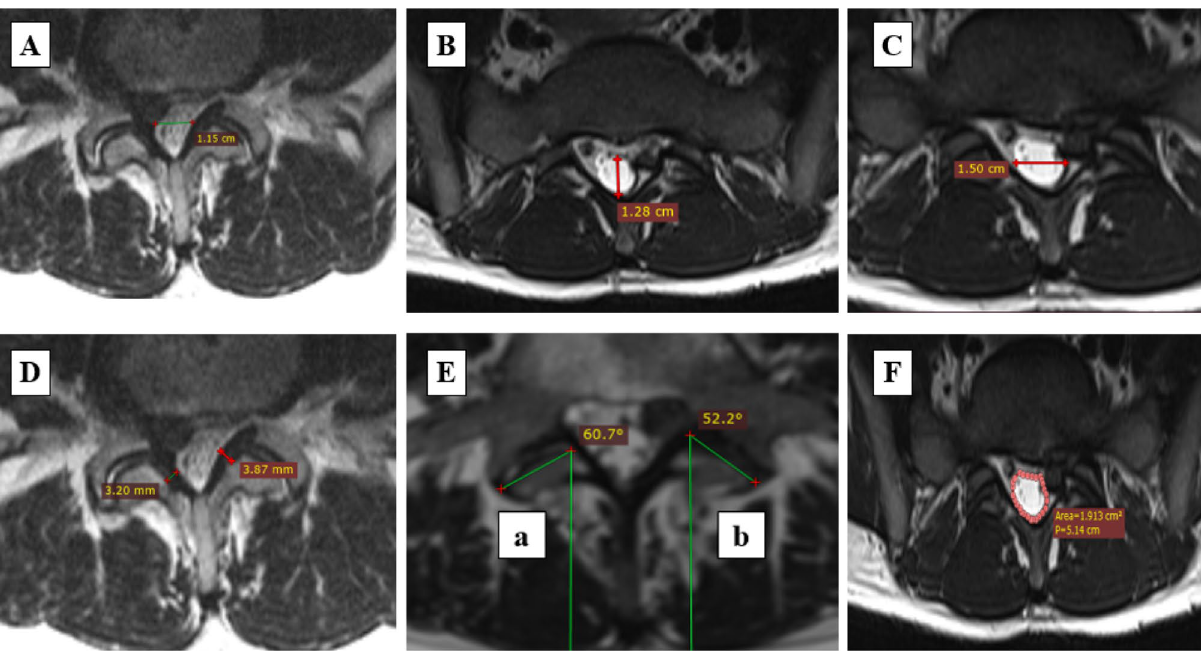
Figure 2. Measurement of ( A ) ligamentous interfacet distance, ( B ) anteroposterior diameter of dural sac, ( C ) laterolateral diameter of dural sac, ( D ) thickness of LF on both sides, ( E ) average facet joint angle measured according to formula: (a + b)/2, ( F ) dural sac